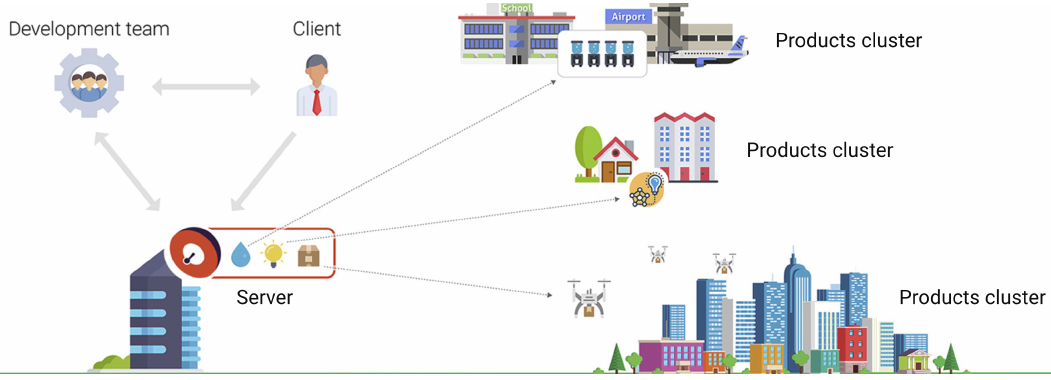
Figure 1. The IoT